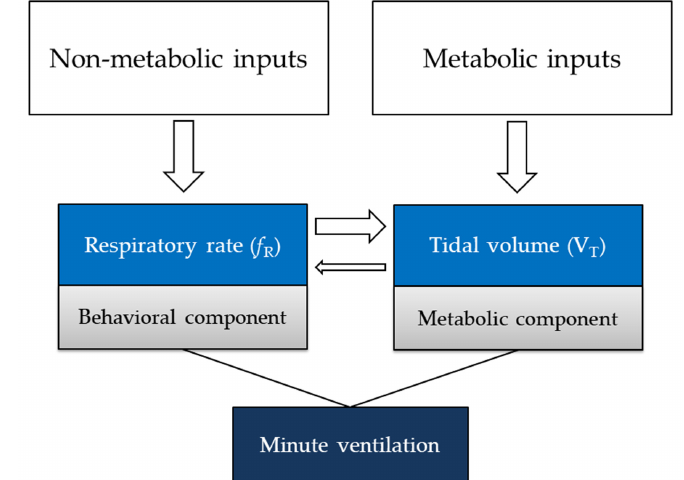
Figure 3. Schematic representation of a simple model of ventilatory control (see Nicolò and Sacchetti [22] for further information). While respiratory rate (the behavioral component of minute ventilation) is substantially influenced by non-metabolic stressors, V T (the metabolic component of minute ventilation) satisfies the metabolic requirements of the human body. As such V T is fine-tuned according to the levels of respiratory rate and the magnitude of metabolic inputs, while f R is influenced by V T to a lesser extent. This model explains why f R is more sensitive than V T to a variety of non-metabolic stressors and corroborates the importance of f R monitoring in di ff erent fields of